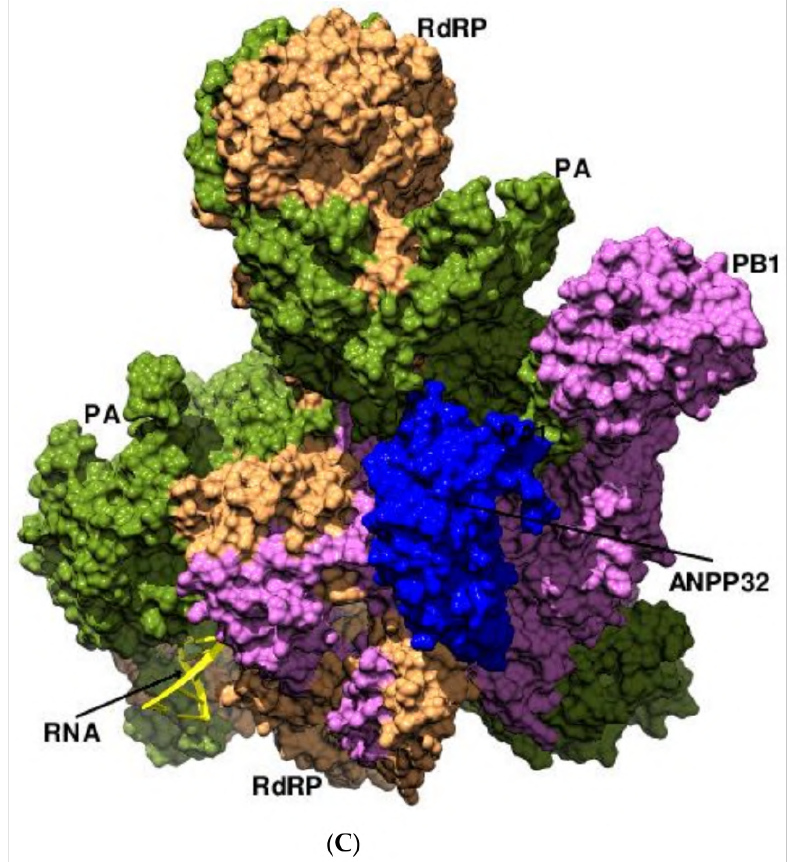
Figure 4. The association of the P domain of HPMV with the L. ( A ) The figure shows the interaction of the coiled-coil domain of the P (residues 169-195) with the L protein (PDB 6U5O). The four helices of the tetrameric P domain are shown as yellow ribbons, and the important domains of L are indicated in different colors in surface representation. ( B ) The superposed structure of HRSV (PDB 6PZK, blue ribbon), PIV5 (PDB 6V85, gray ribbon), and HPMV (PDB 7ORL, green ribbon) RdRPs and their corresponding P domains. The strong resemblance between the structural conformations of HPMV and HRSV and their association with P is observable. The large conformation shift of the MTase, CBD, and CTD of PIV5 with respect to the mononegaviral L–P complex is obvious, though the P interactions seem similar. ( C ) Cooperative binding of ANPP32 to two copies of FluC polymerase during replication (PDB 6XZQ). The structures of human FluC polymerases (RdRP: brown, PA: green, PB: orchid, RNA: yellow) bound to the amino-terminal leucine-rich repeat domain of ANP32A (blue) are shown. The ANPP32 plays a pivotal role during replication by stabilizing the replication